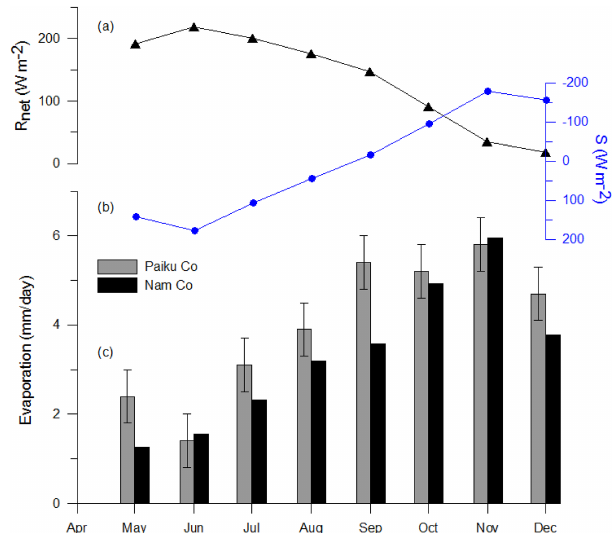
Figure 6. Comparison of monthly lake evaporation with net radia- tion ( R net ) and changes in lake heat storage ( S ). (a) Net radiation, (b) changes in lake heat storage, and (c) lake evaporation from Paiku Co and Nam Co on the central TP. Lake evaporation from Nam Co was determined using the eddy covariance system in the lake cen- ter (B. Wang et al., 2019). The bars denote the uncertainty of lake evaporation from Paiku